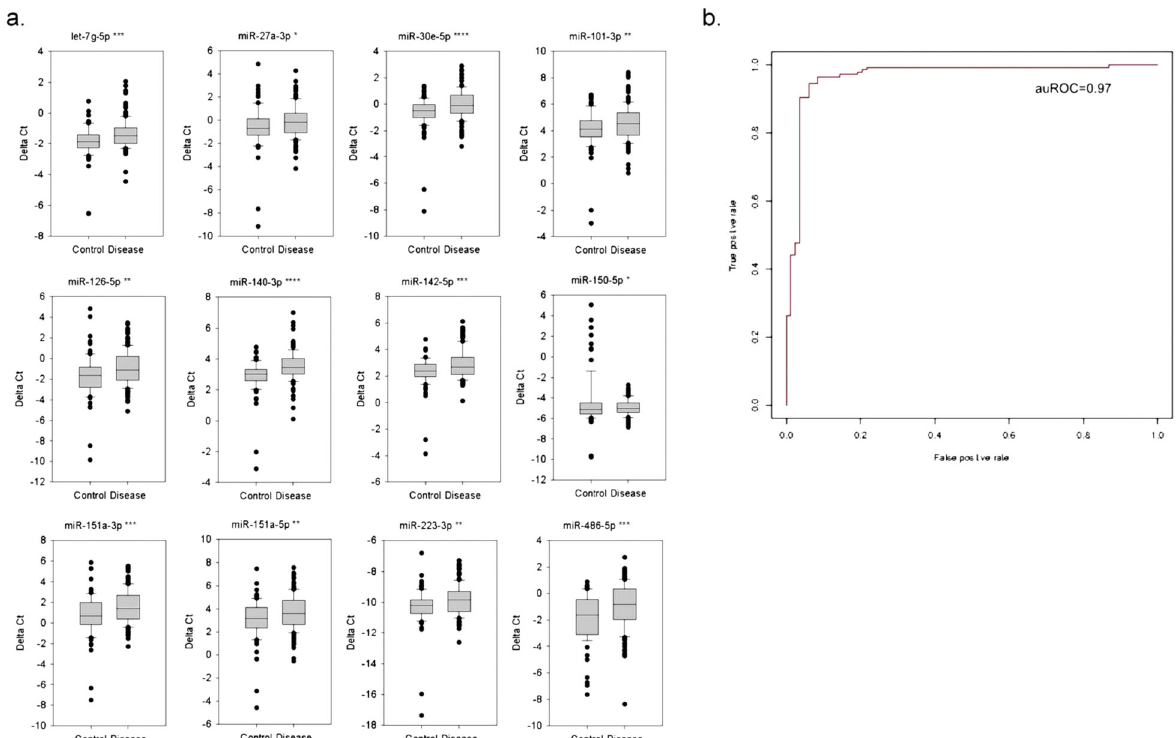
Fig. 1 The miRNA expression pro fi le and ADHD prediction model. a We evaluated 12 miRNA expression pro fi les in total WBCs from either healthy control (control, N = 83) subjects or ADHD patients (disease, N = 145). RNU44 was adopted as the internal control gene. b We used the delta Ct values of 12 miRNAs to develop an ADHD prediction model with an auROC value of 0.97. The p values of comparisons were derived with a t -test. *, **, *** and **** denote p value < 0.05, p value < 0.01, p value < 0.001, and p value < 0.0001,